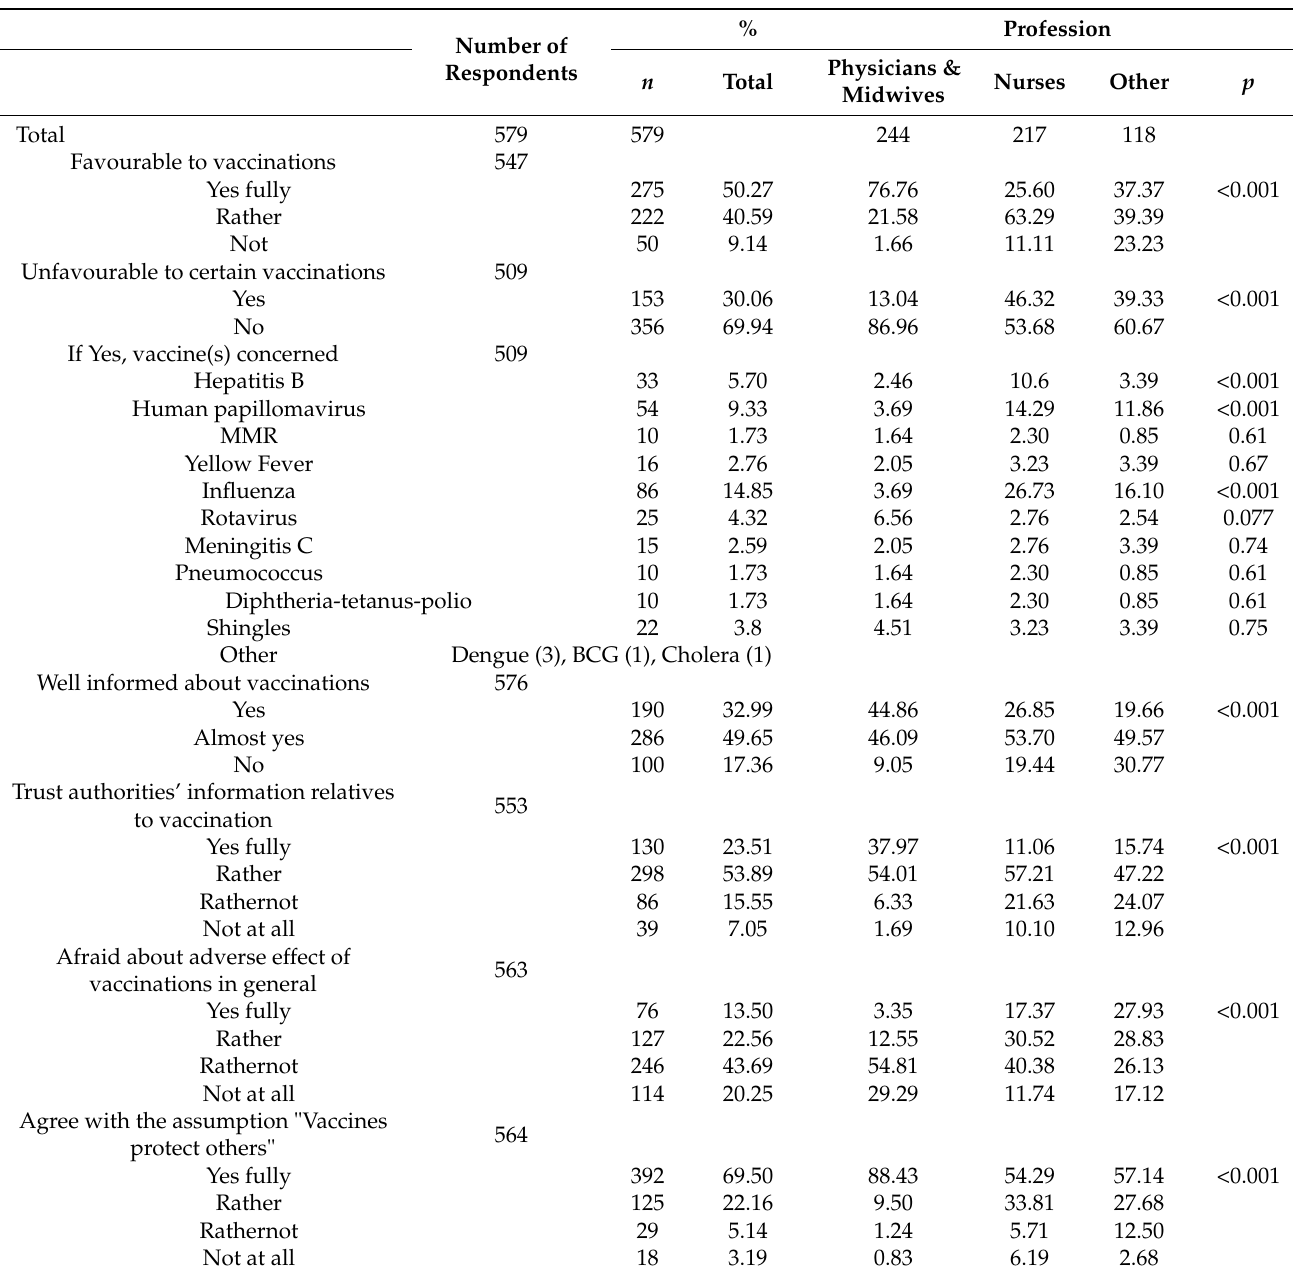
Table 3. Attitudes towards vaccines in